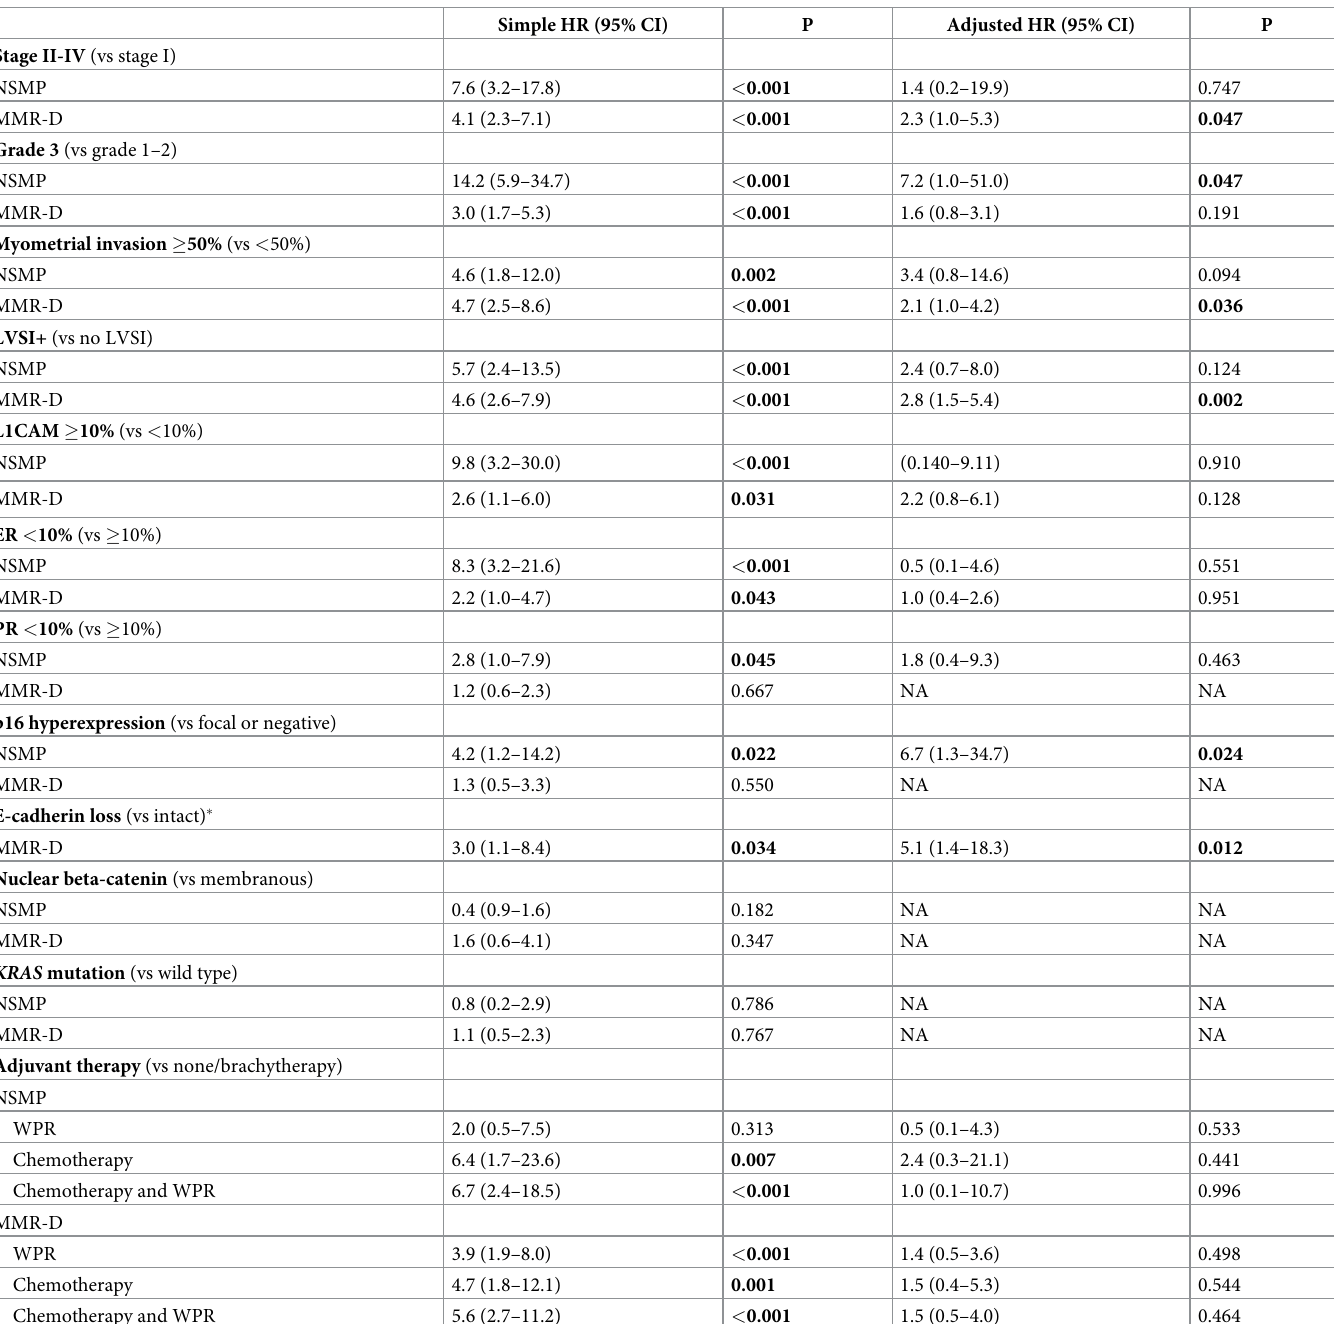
Table 2. Subgroup-specific simple and multivariable Cox regression analysis of disease-specific survival in NSMP (n = 206) and MMR-D (n = 264) stage I-IV